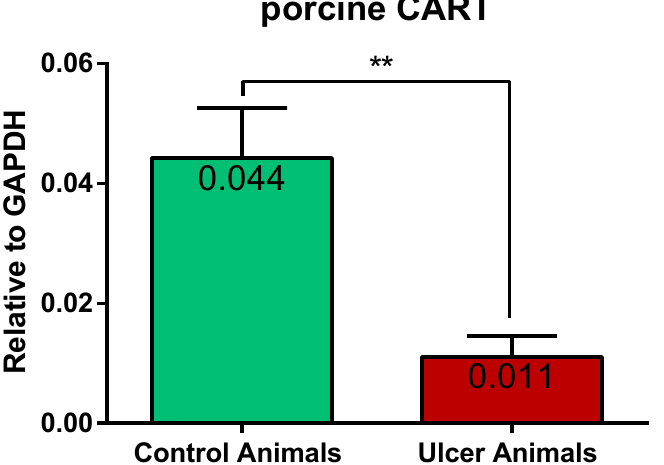
Figure 9. Graph showing the expression level of mRNA encoding CART in the stomach antrum tissues of the control and ulcer pigs. The stomach antrum circular-shaped samples (directly adjacent to the ulcer verge in experimental animals; at the strictly equivalent location in control animals) were cut transversally to the gastric wall and comprised all its layers. The data obtained from each sample were normalized to GAPDH. Relative quantities (RQ) of mRNA were analyzed using the comparative Ct method. (**) p value = 0.0043.